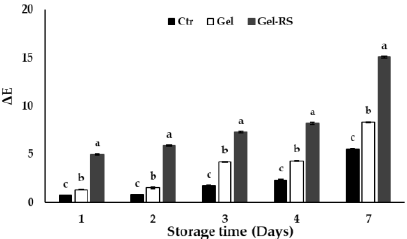
Figure 4. ∆ E values of coated fresh cut zucchini samples during a 7-day storage period at 5 ◦ C. Black columns indicate Ctr treatment; white columns indicate Gel treatment and grey columns indicate Gel-RS treatment. Different letters indicate statistical differences. Different letters within the columns indicate significant differences ( p < 0.05) among the different treatments on every sampling date. Sample analysis was in triplicate.